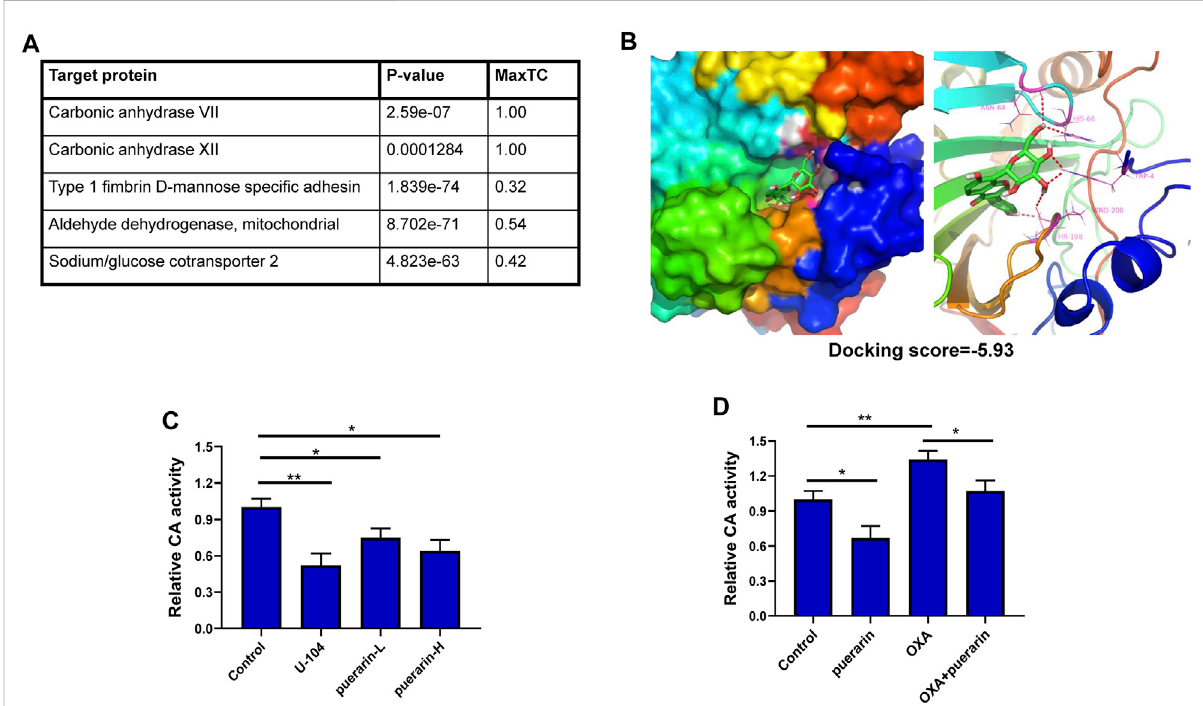
CAXII isapotential drug targetofpuerarin. (A) The predictedtargetsfor puerarin (B) The moleculardockingresults showed that there isagood combination between puerarin and CA XII, with the docking score -5.93. (C) Puerarin could inhibit CA activity under a dose-effect relationship (D) Low dose OXA treatment increased the extracellular pH level compared with the control group, and puerarin inhibited this trend (* p < 0.05, ** p <